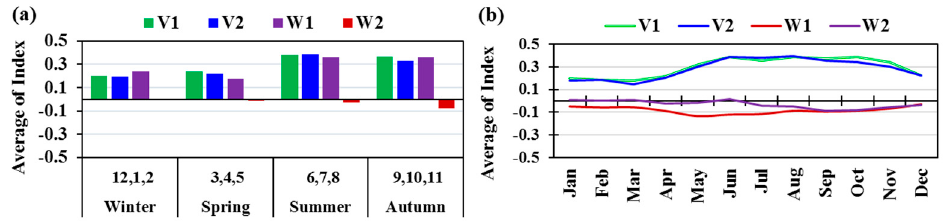
Figure 4. Average of the indices at the selected points: V1 and V2 (NDVI), W1 and W2 (NWDI): ( a ) Seasonal; ( b ) Monthly.